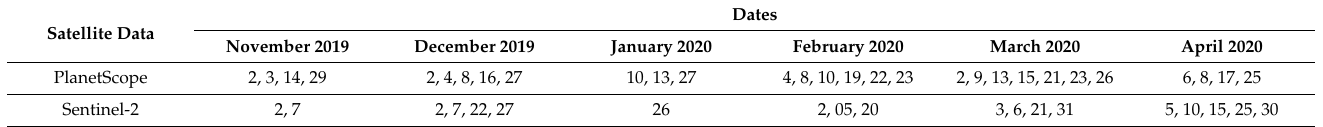
Table 1. Dates of the satellite data used during maize growing season, from November 2019 to April 2020, in the investigated test sites in